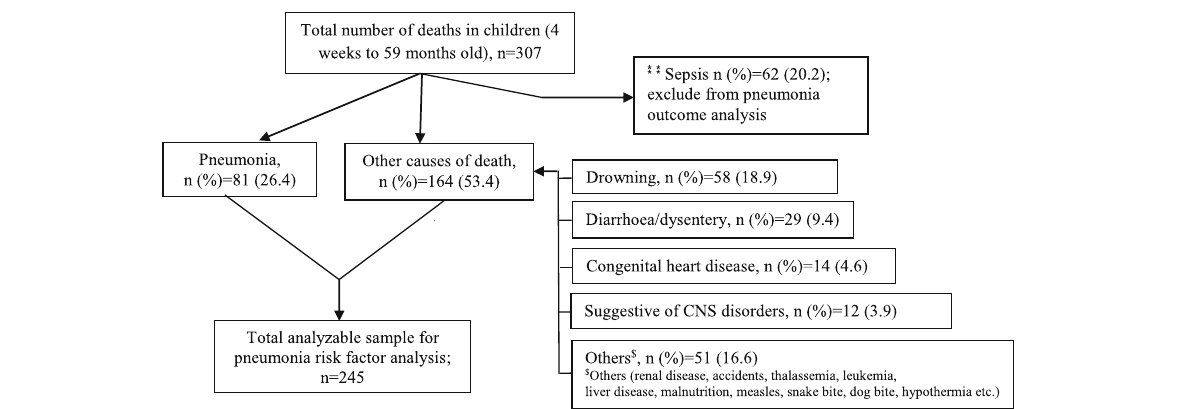
Fig. 1 Flowchart of primary causes of death of children aged 4 weeks – 59 months. ⁑⁑ To avoid overlapping clinical features, sepsis deaths ( n = 62) were excluded from the analysis of risk factors for death from